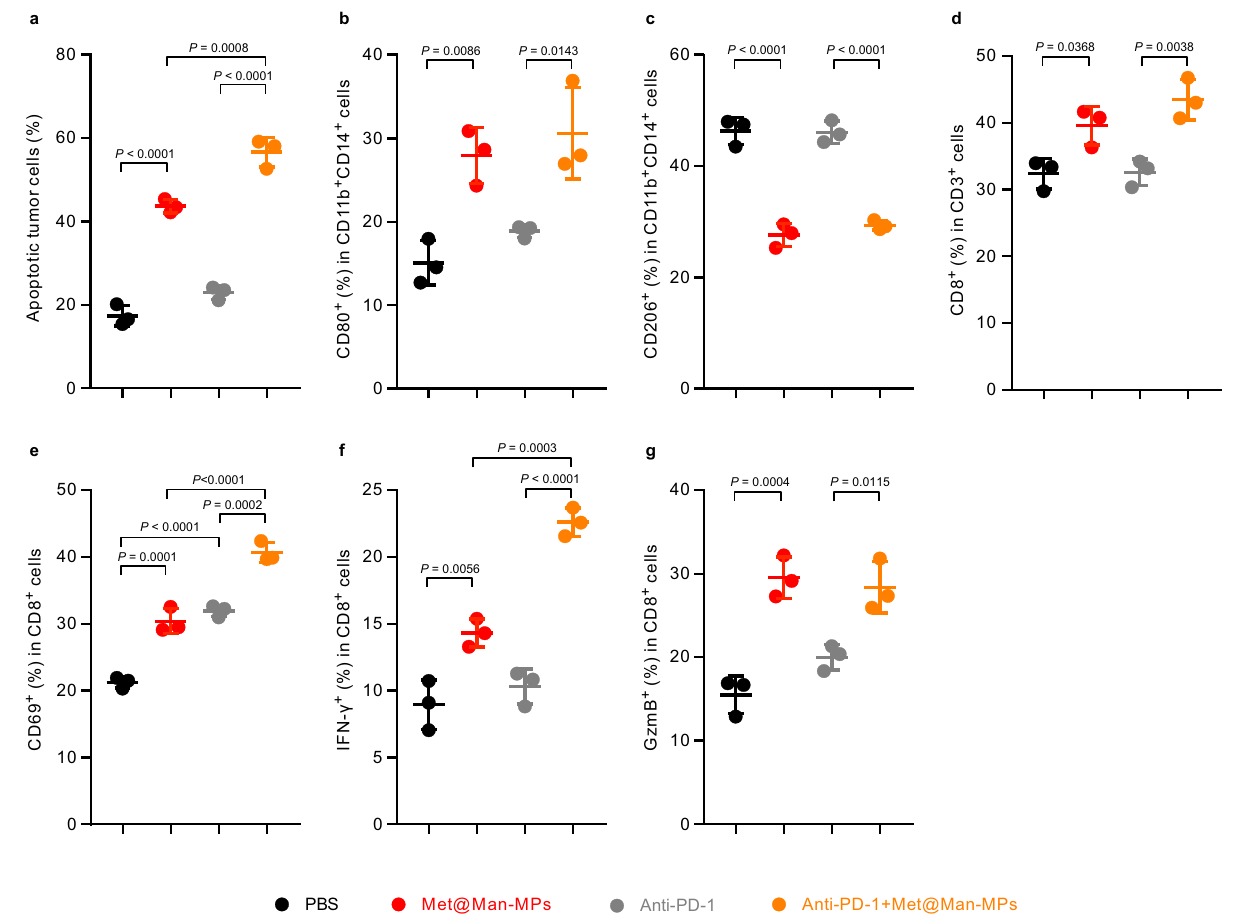
Fig. 10 Apoptosis and improved tumor immune microenvironment induced by combination of anti-PD-1 antibody and Met@Man-MPs in organotypic slices from one liver cancer patient-derived tumor. a The ratio of apoptotic tumor cells (CD45 − cells) after the tumor slices from patient-derived tumor were treated with anti-human PD-1 antibody, Met@Man-MPs derived from THP-1-origniated macrophages or Met@Man-MPs plus anti-human PD-1 antibody at the concentration of anti-PD-1 antibody and Met of 20 and 40 μ g mL − 1 in the presence of PBMCs for 36 h, respectively. Data are presented as mean ± s.d. ( n = 3 biologically independent samples; one-way ANOVA followed by Tukey ’ s HSD post-hoc test). ( b – g ) Percentages of M1-like TAMs ( b ), M2-like TAMs ( c ), CD8 + T ( d ), CD8 + CD69 + T ( e ), CD8 + IFN- γ + T ( f ), and CD8 + GzmB + T cells ( g ) in the tumor slices from patient-derived tumor after treatment with anti-human PD-1 antibody, Met@Man-MPs derived from THP-1-origniated macrophages or Met@Man-MPs plus anti-human PD-1 antibody at the concentration of anti-PD-1 antibody and Met of 20 and 40 μ g mL − 1 in the presence of PBMCs for 36 h, respectively. Data are presented as mean ± s. d. ( n = 3 biologically independent samples; one-way ANOVA followed by Tukey ’ s HSD post-hoc test). Source data are provided as a Source Data fi